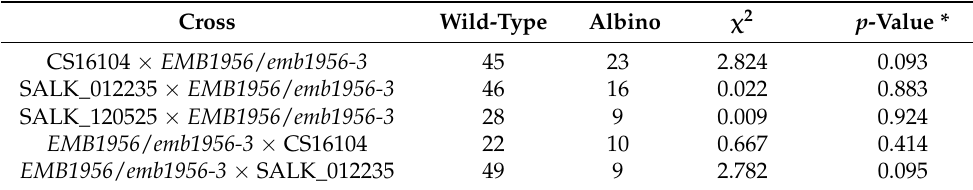
Table 2. Segregation of collapsed seeds in F 1 progenies of complementation crosses. Cross Wild-Type Albino χ 2 p -Value